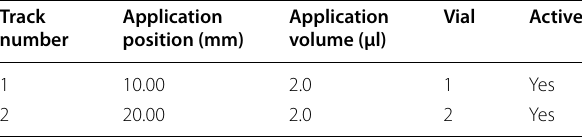
Table 2 Tracks representing sample position and volume